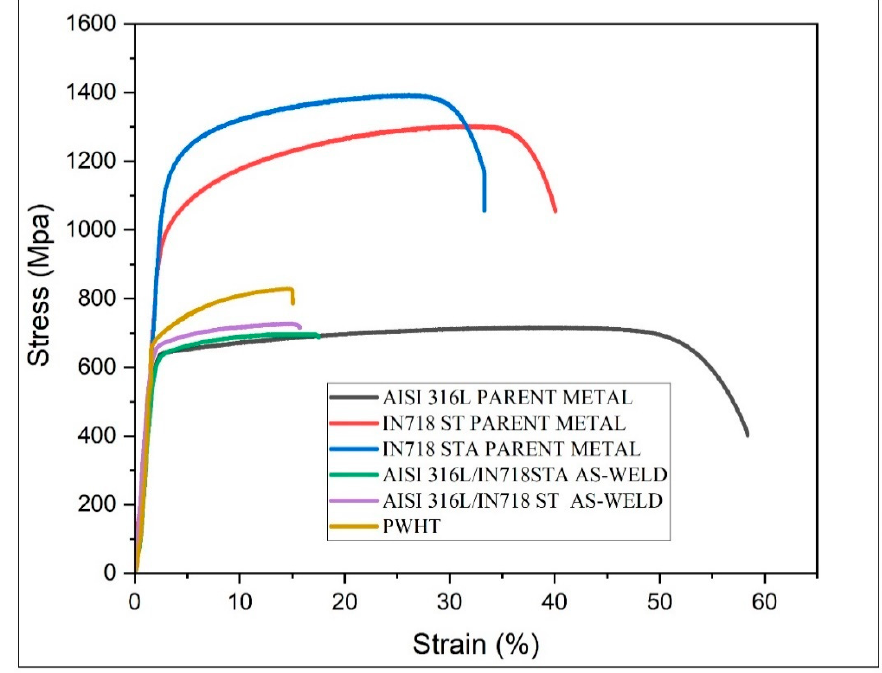
Figure 11. Typical tensile curves of parent metals and friction welded joints. Table 5. Results of tensile testing of dissimilar friction welds AISI316L/IN718ST, AISI316/IN718STA, PWHT, and parent